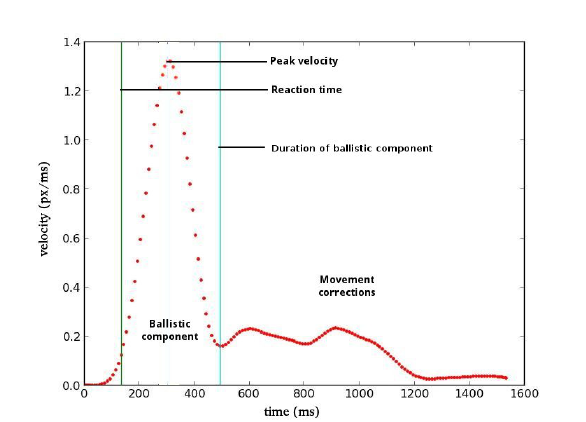
Figure 4. Example of a velocity profile with various temporal metrics illustrated. movement velocity exceeded 7% of the peak velocity (Figure 4). Various methods